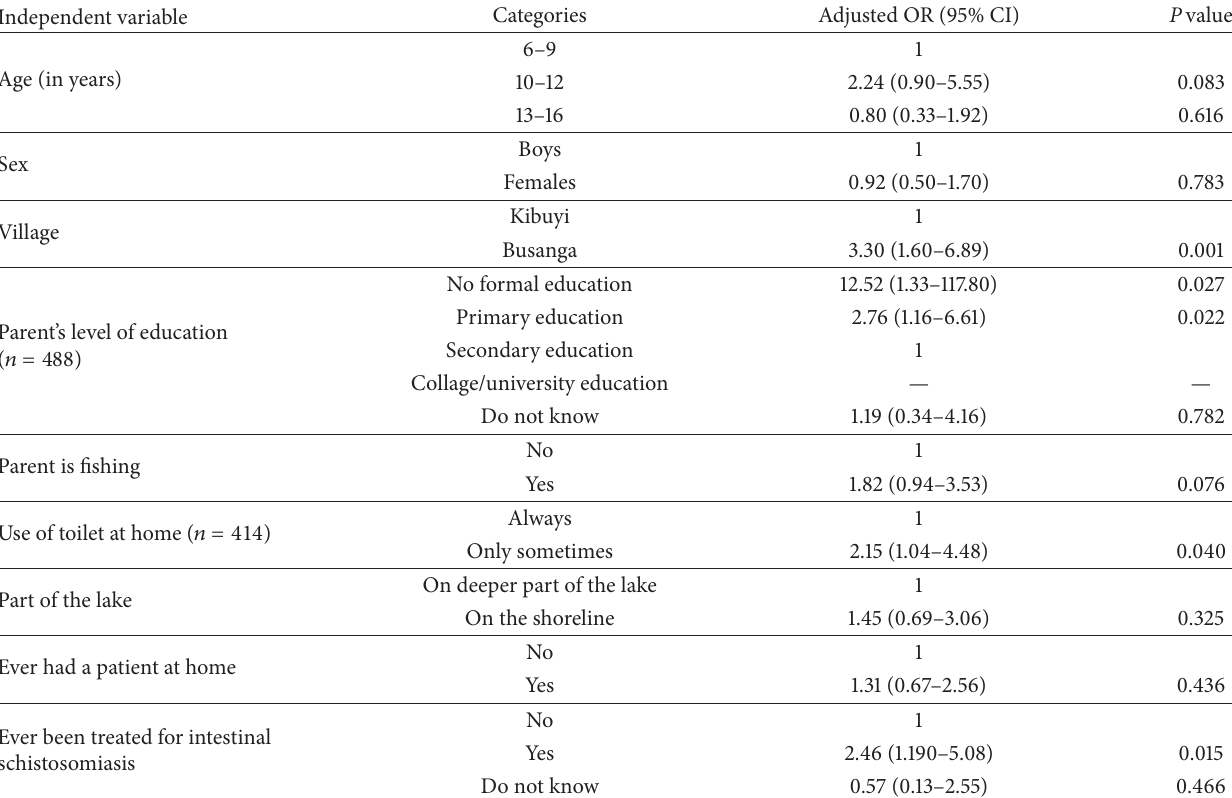
Table 4: Multivariate logistic regression for factors associated with Schistosoma mansoni infection. Independent